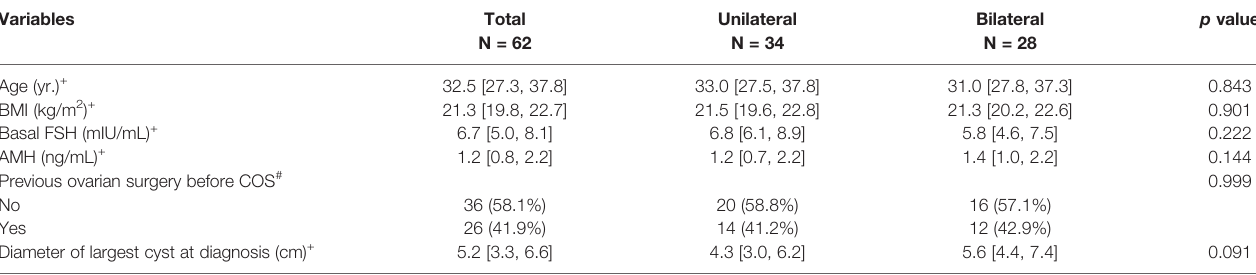
TABLE 1 | Basal characteristics of the patients with endometrioma according to laterality. Variables Total Unilateral